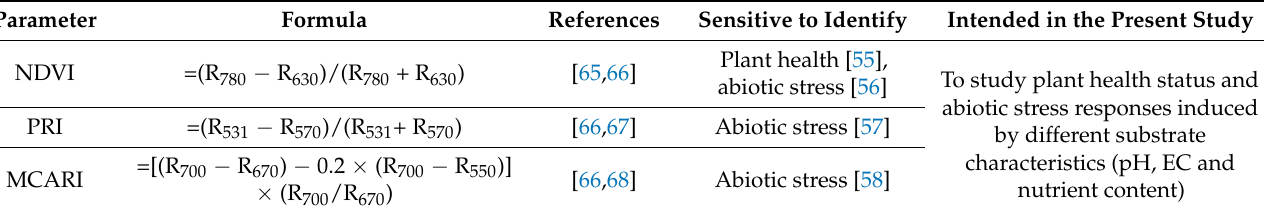
Table 4. Evaluated spectral vegetation indices